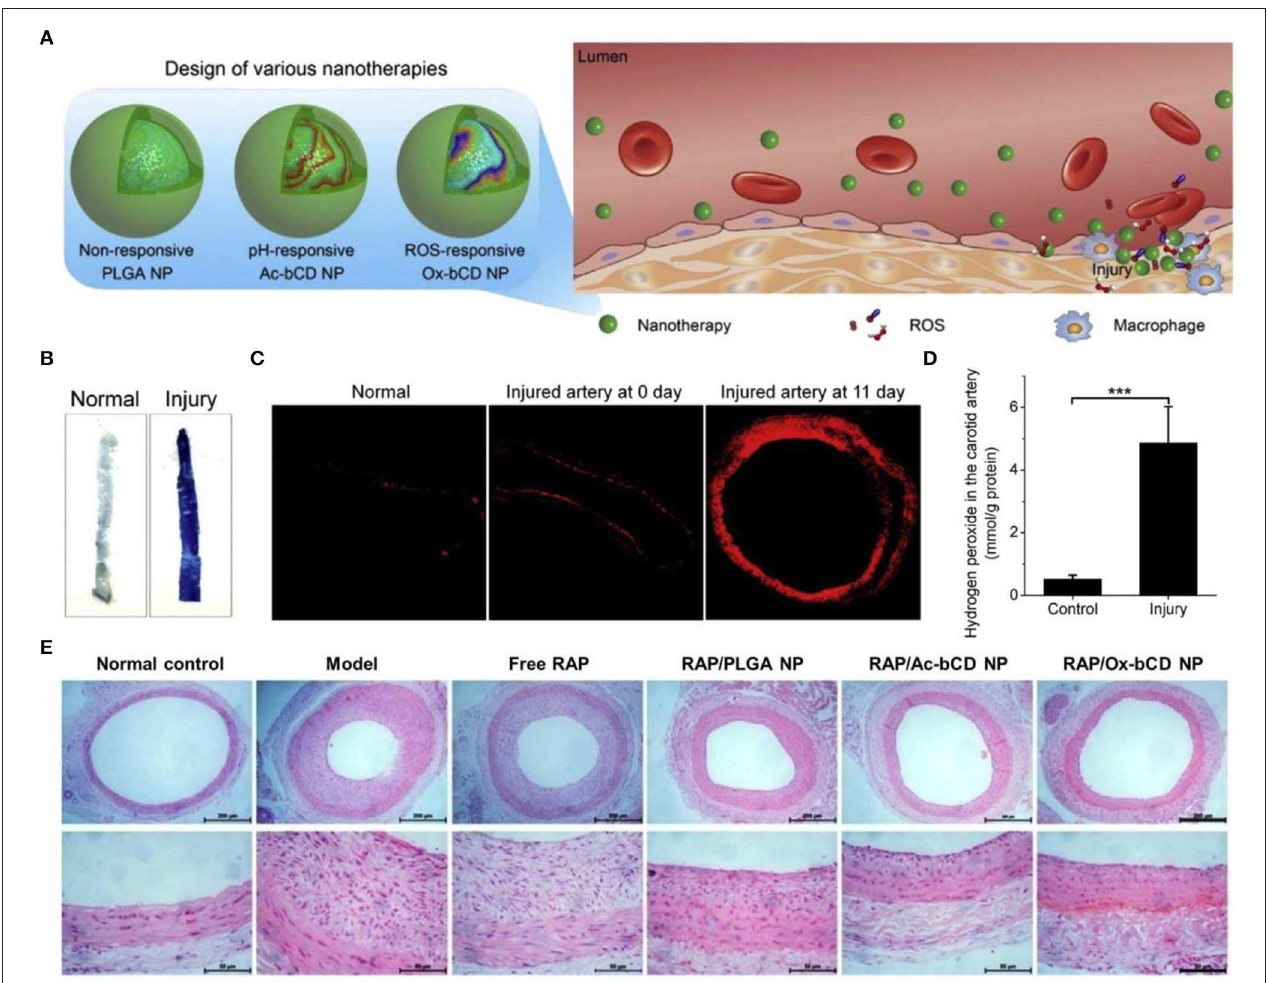
FIGURE 6 | Engineering of different inflammation-responsive nanotherapies for targeted treatment of restenosis. (A) Design of inflammation-triggerable nanoparticles. (B) Evans Blue staining indicates successful establishment of injury in the carotid artery. (C) DHE-stained cryosections showing oxidative stress in injured carotid arteries. The image at day 0 was acquired from the sample immediately collected after injury. (D) The levels of hydrogen peroxide in the carotid artery with or without injury. (E) H&E stained histological sections of carotid arteries isolated from rats subjected to various treatments. Scale bars, 200 µ m (the upper panel), 50 µ m (the lower panel). PLGA NP, Ac-bCD NP, and Ox-bCD NP represents nanoparticles based on a non-responsive polymer PLGA, a pH-responsive material of acetelated β -CD, and a ROS-responsive material of PBAP-conjugated β -CD, respectively. Data are mean ± standard deviation ( n = 3). *** P < 0.001. Reproduced with permission from Feng et al.